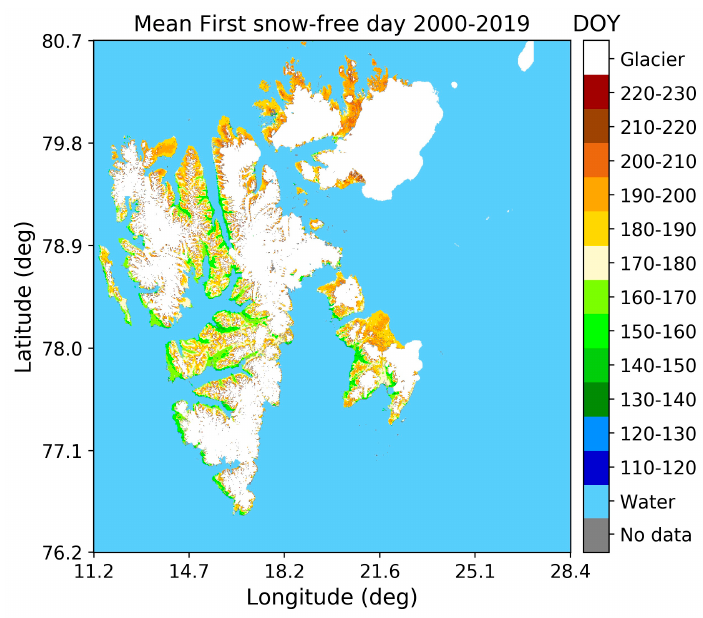
Figure 6. Mean FSFD for 2000–2019.